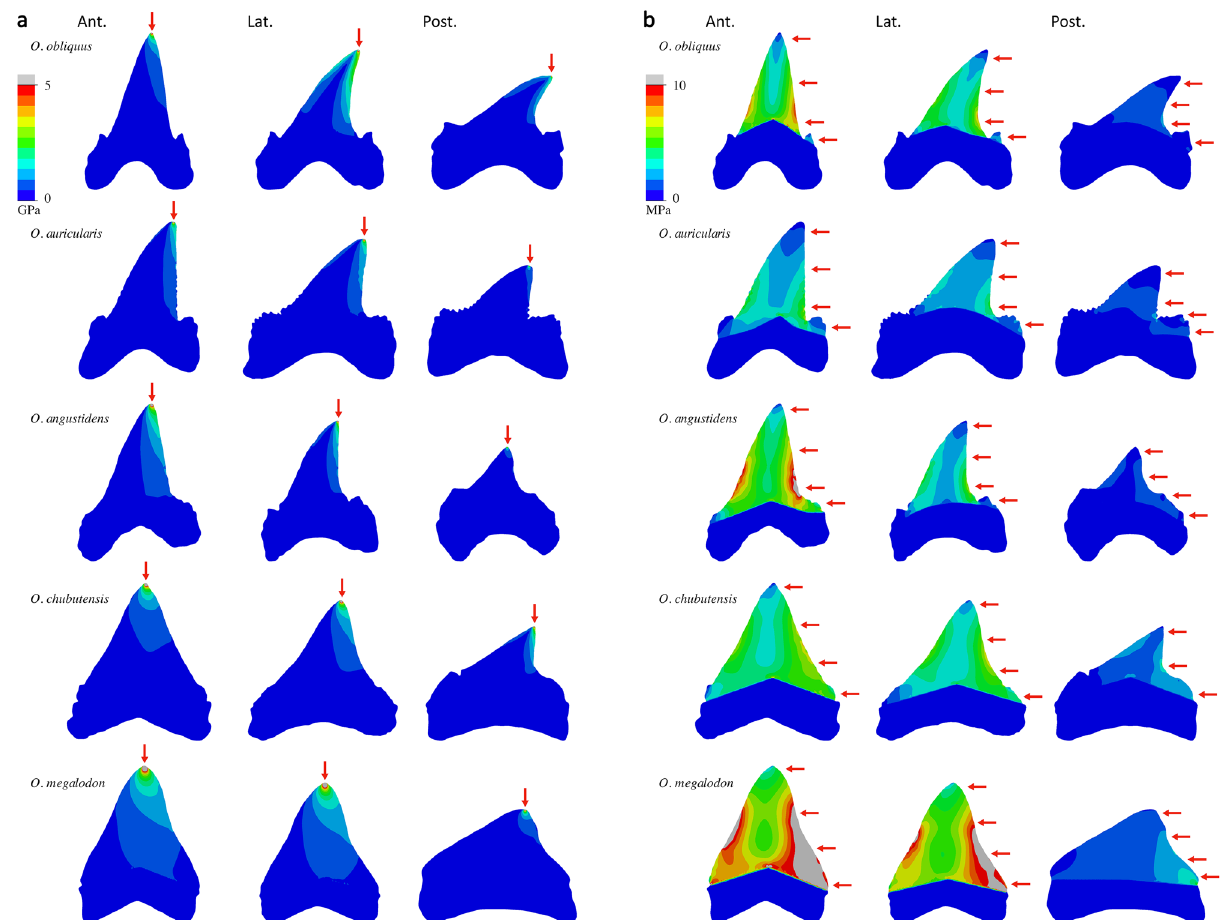
Figure 1. Von Mises stress distribution plots in the anterior ( Ant. ), lateral ( Lat. ), and posterior ( Post. ) teeth of the five analysed otodontid species, simulating ( a ) puncture and ( b ) draw scenarios with scaled force magnitude. Mesial is left, distal is right. Arrows indicate loading points. Grey areas represent von Mises stress values higher than 5 GPa and 10 MPa in each of the scenarios,